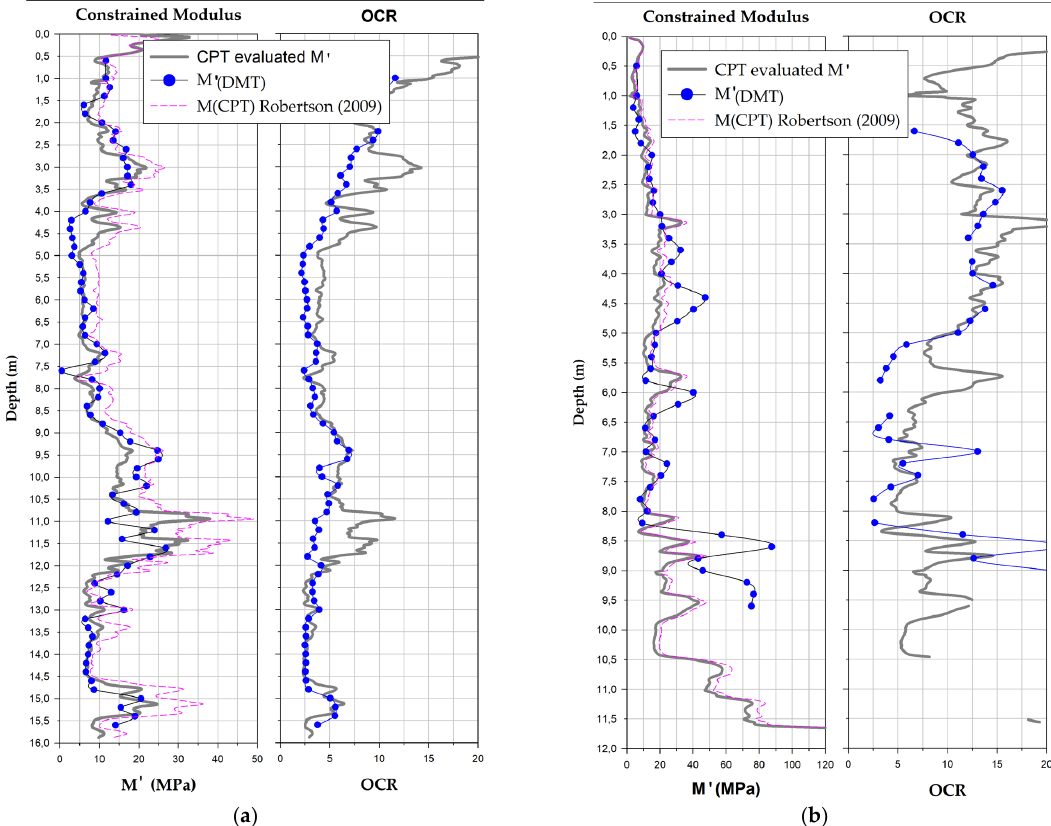
Figure 17. Vertical profiles of the comparison of CPT - evaluated M′ vs. measured M′ DMT and M(CPT) Robertson, side diagram is for OCR CPT vs. OCR DMT for the pair of in-situ probes. Continuous grey line on the chart is a result for the CPT - evaluated M’ ; the blue dotted line is obtained from DMT data, pink dashed line is the M(CPT) from expression by Robertson: ( a ) for the site — Dugo Selo; ( b ) for the site— Bedekovčina.